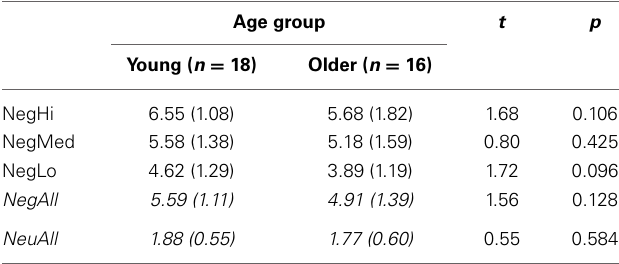
Values before parentheses indicate the means. Values in parentheses indicate standard deviations. Reported p-values are two-tailed.